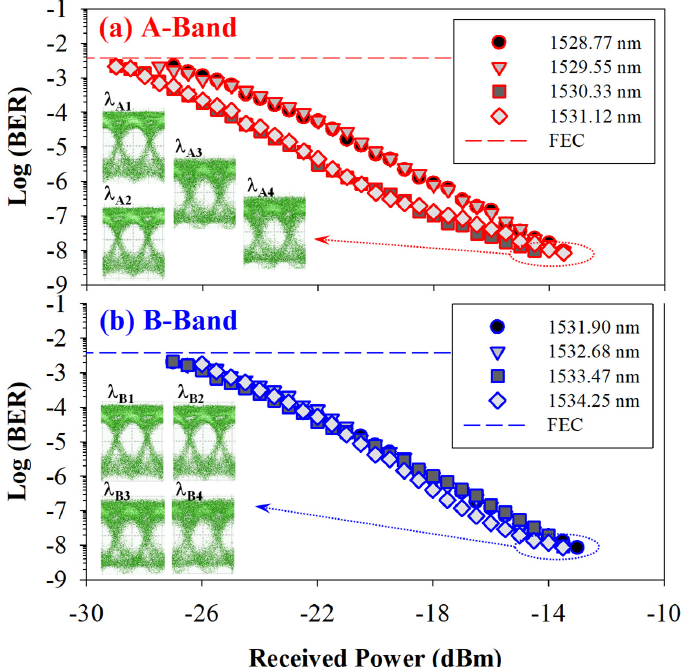
Figure 5. ( a ) Measured 24.3 Gbit/s BER performances of λ A1D to λ A4U via FSO fiber path through 25 km fiber link and 2 m free space link. ( b ) Obtained BER measurements of λ B1D to λ B4U in the original FSO fiber path after 24 km fiber and 2 m wireless FSO connections. Insets are the corresponding eye diagrams of eight selected